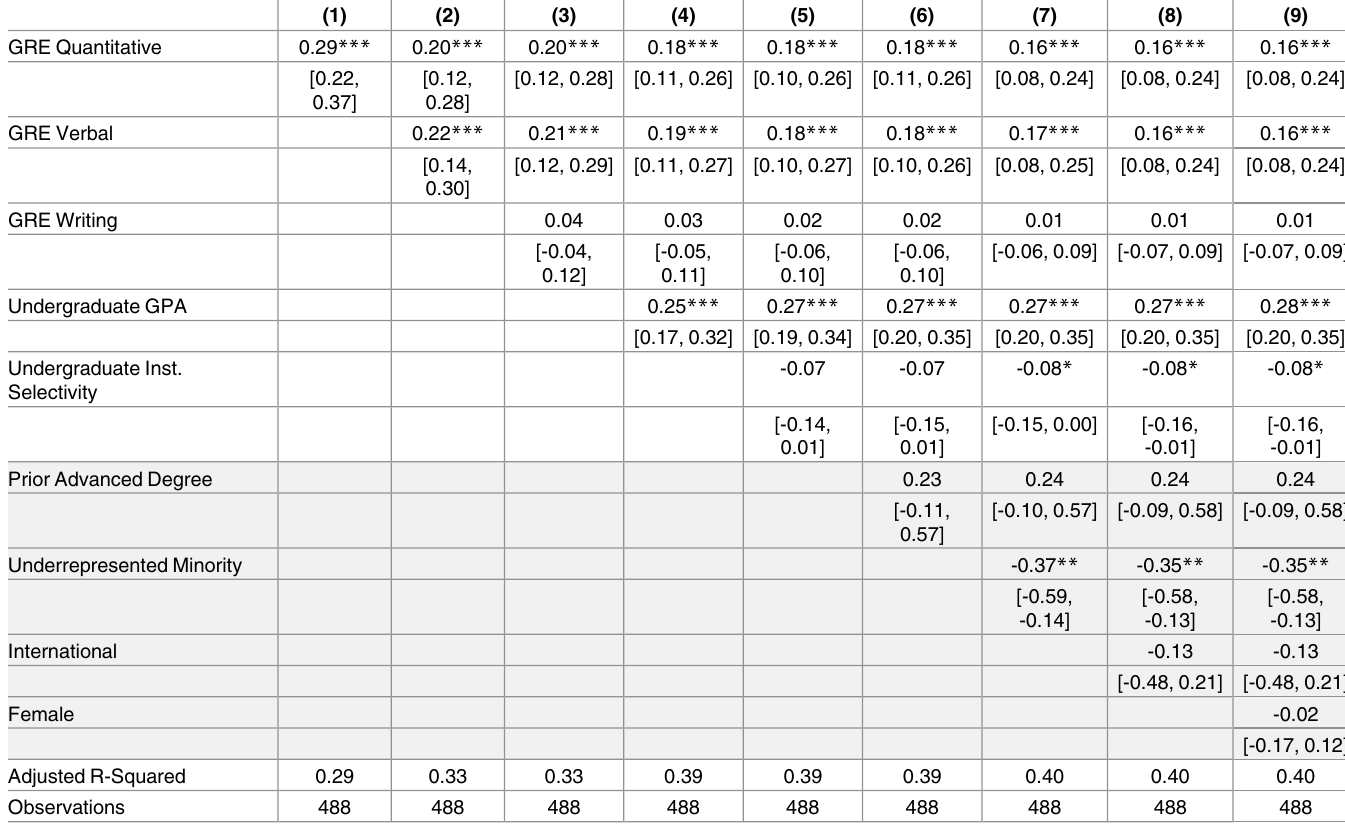
Table 3. The predictive power of GRE scores and other admissions criteria on First SemesterGrades.